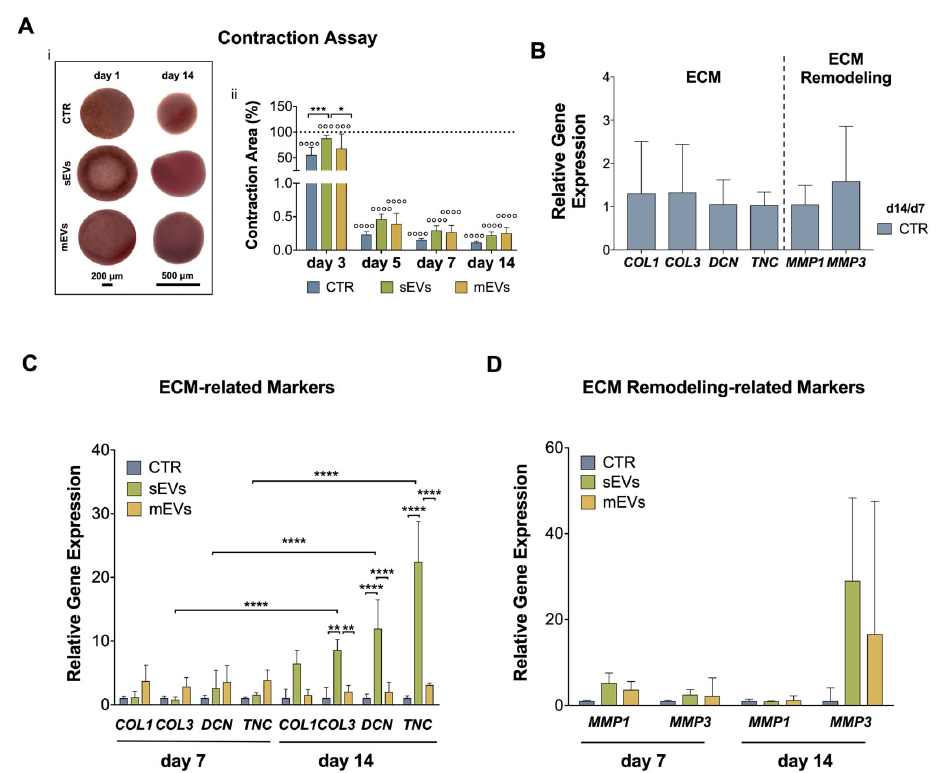
Figure 5. EVs’ role on matrix deposition by hASCs encapsulated in yarns. ( A ) Collagen contraction assay. i — representative pictures of collagen hydrogel loaded with hASCs either with or without EVs over time. Scale bars: 200 μ m and 500 μ m. ii — collagen gel contractility area after 3, 7, and 14 days, respective to day 1. Data are presented as mean ± SD. Statistical differences: * p < 0.05, *** p < 0.001, °°° p < 0.001, °°°° p < 0.0001 (° against day 1). ( B ) Control day 14/control day 7 ratio of ECM markers. ( C ) Gene expression of ECM deposition markers COL1A1, COL3A1, DCN, and TNC, and ( D ) ECM turnover markers MMP1 and MMP3 after 7 and 14 days. Target genes were normalized to the reference genes GADPH and GUSB. Gene expression results are presented as fold changes with respect to the control group at each time point. Statistical significance: ** p < 0.01, **** p < 0.0001. to synthesize and remodel the ECM, the gene expression of a range of tendon matrix markers was evaluated. On control samples (no EVs), the expression of the tendon ECM components, including collagen type 1 ( COL1A1 ), collagen type 3 ( COL3A1 ), the glycoproteins decorin ( DCN ), and tenascin ( TNC ), decreased over time (Figure 5B). On the contrary, the expression of ECM ‐ remodeling enzymes, such as metalloproteinases − 1 and − 3 ( MMP1 and MMP3 ), was significantly upregulated from day 7 to day 14 of culture